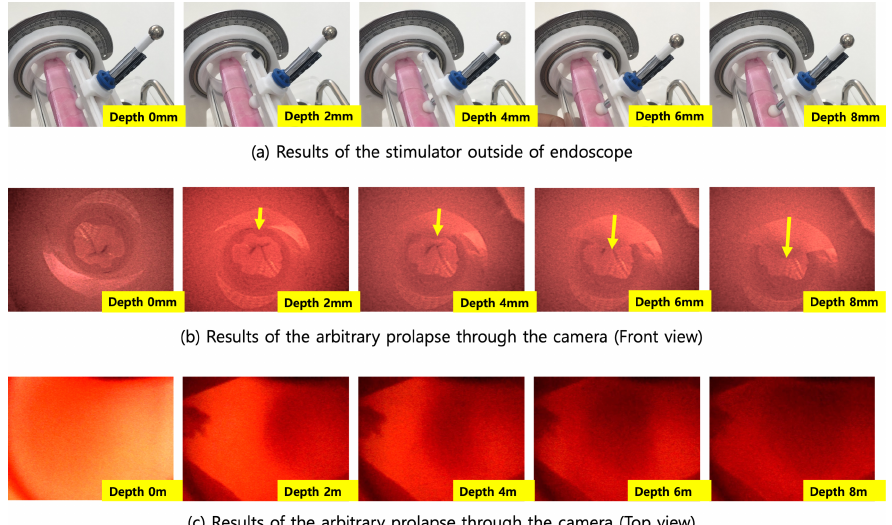
Figure 8. Results of observed arbitrary prolapse through the camera, subject to the condition of the stimulator being forced outside the endoscope.